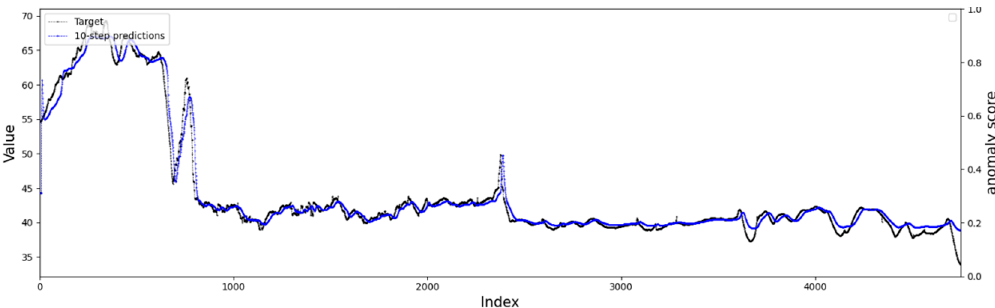
Figure 15. The result of the 10-step prediction.